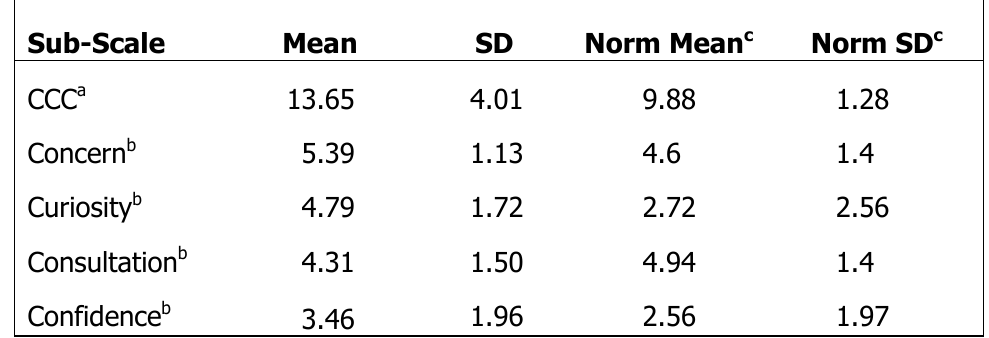
Rank Order of Career Maturity Inventory Sub-Scale Mean Scores